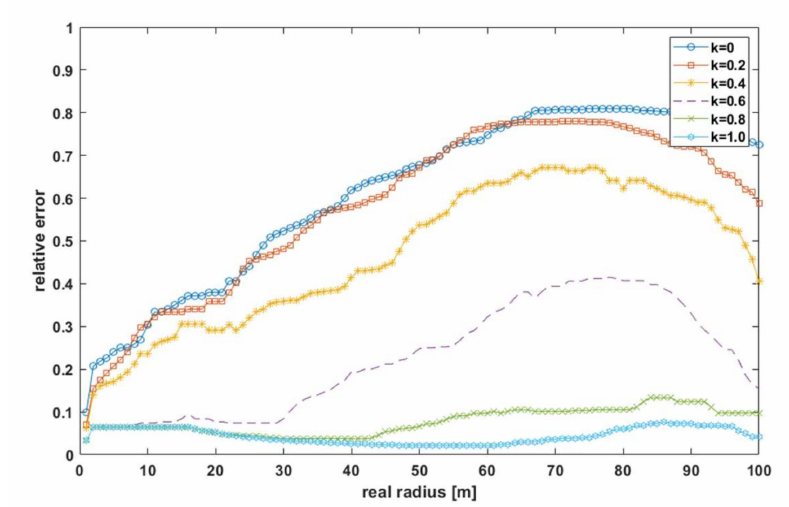
Figure 12. The maximum relative error of the distance estimation for different values of the k